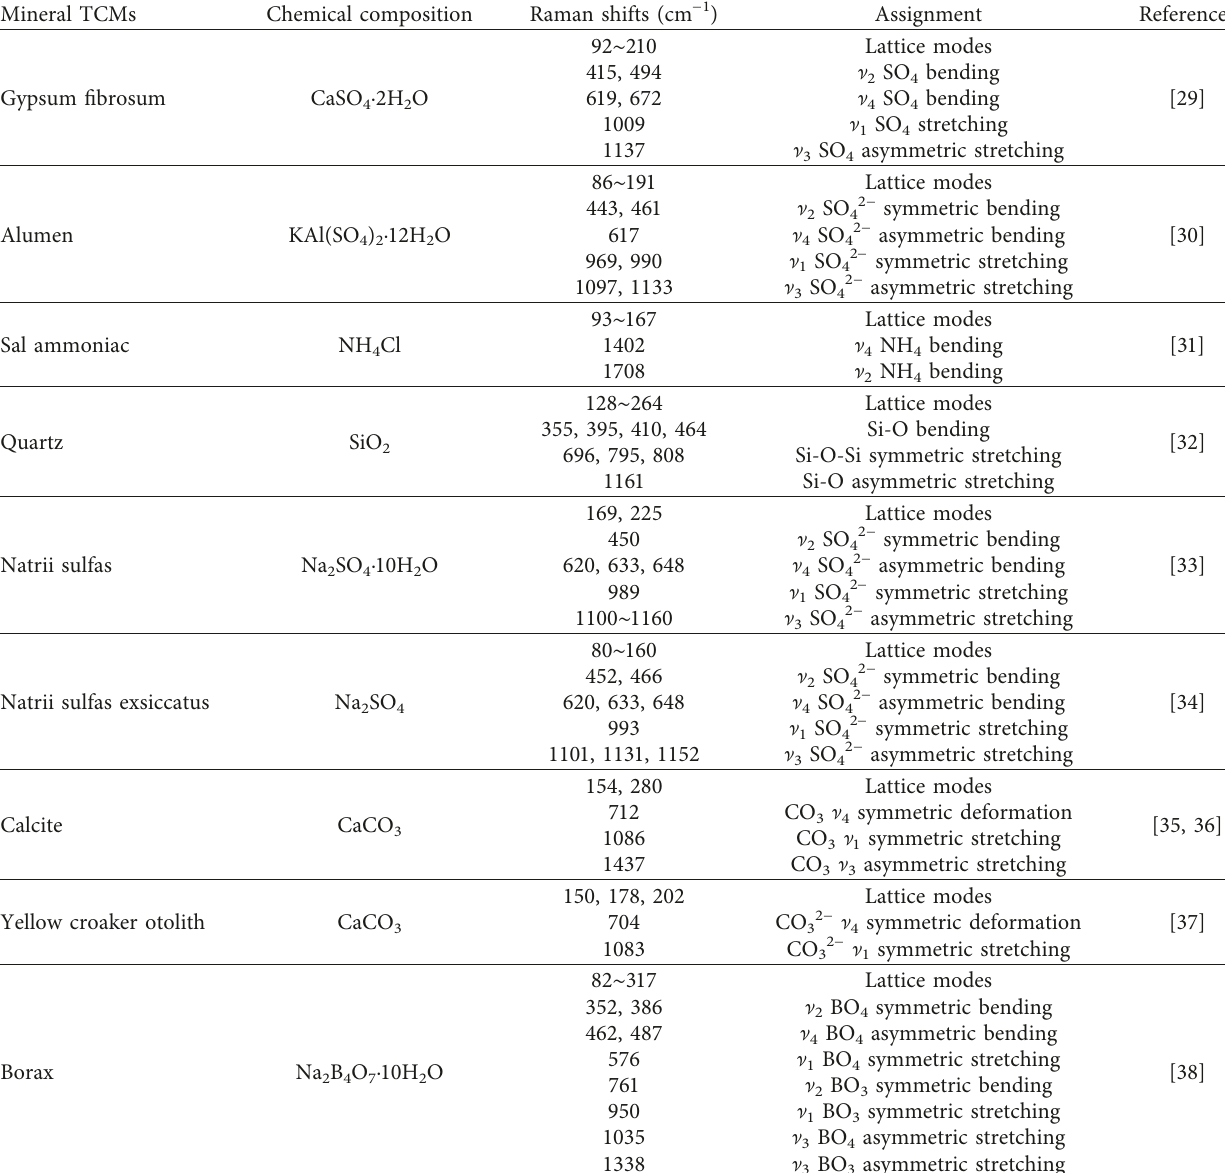
Figure 2: The normalized, baseline corrected average spectra of each medicine: (a) gypsum fibrosum; (b) alumen; (c) sal ammoniac; (d) quartz; (e) natrii sulfas; (f) natrii sulfas exsiccatus; (g) calcite; (h) yellow croaker otolith; (i) borax. Table 2: Peak positions and assignments of Raman